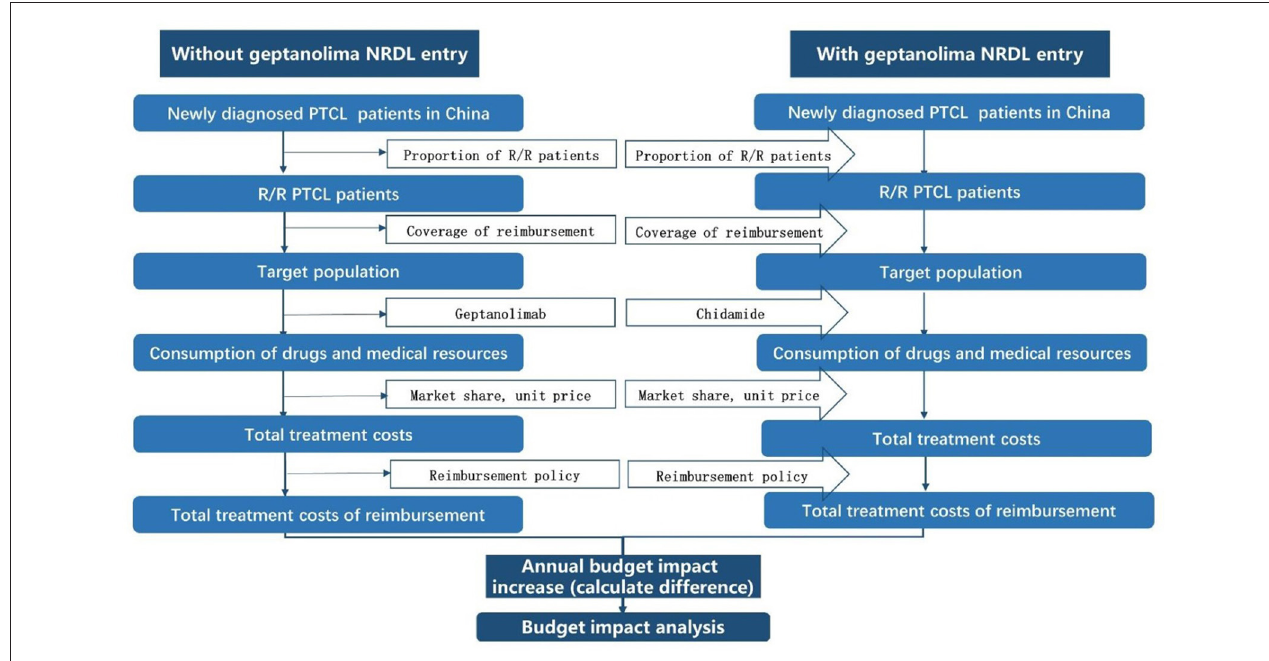
FIGURE 1 | Model structure. NRDL, National Reimbursement Drug List; R/R PTCL, relapsed or refractory peripheral T cell